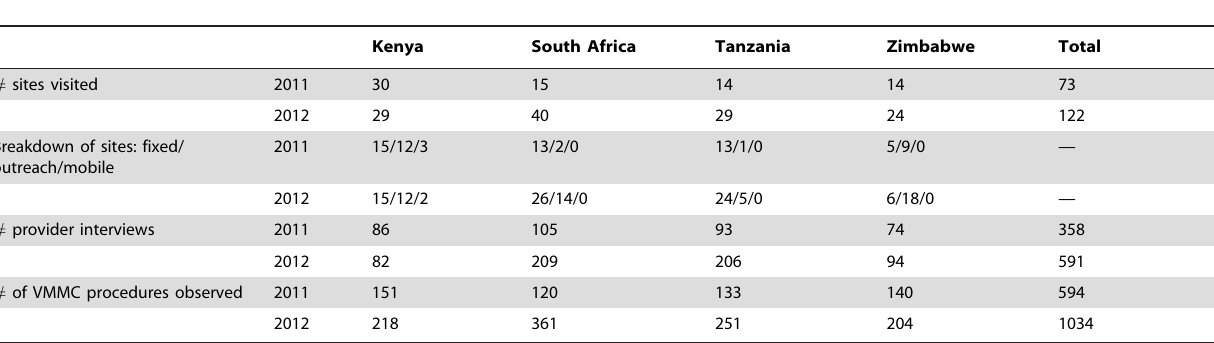
Table 1. Number of sites visited, providers interviewed, and VMMC procedures observed, by year and by country.